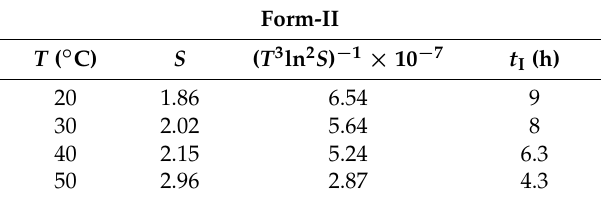
Table 1. Correlation of induction time with respect to parameters of the nucleation